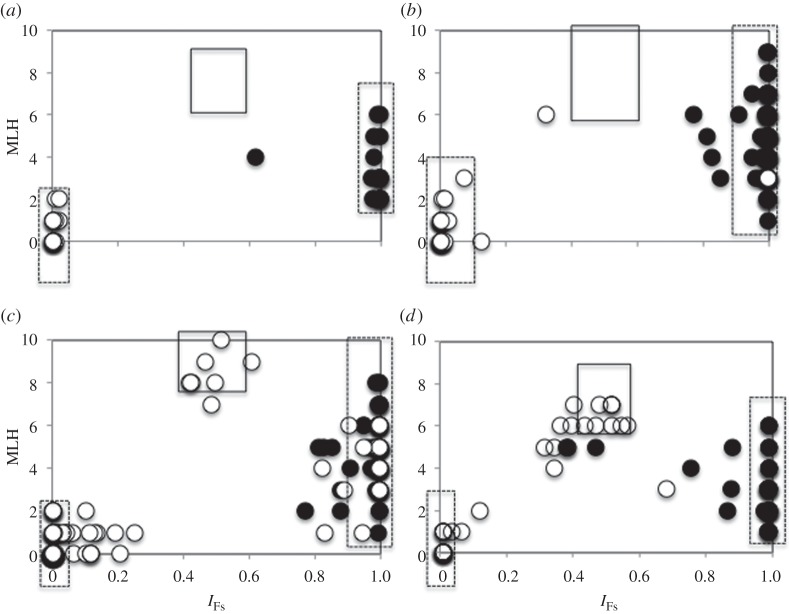
Relationship between individual MLH and introgression (IFS) for the ‘old’ ((a,b) Kirkenes and Tromsø) and the ‘young’ contact zones ((c,d) Blushøj and Heimaey). Boxes depict results from the simulation analysis: stippled=pure species; dark grey=F1 hybrids. Individuals were further classified by the origin of their chloroplasts: open circles=F. distichus, filled circles=F. serratus.